Question: Produce a descriptive caption suitable for publication.
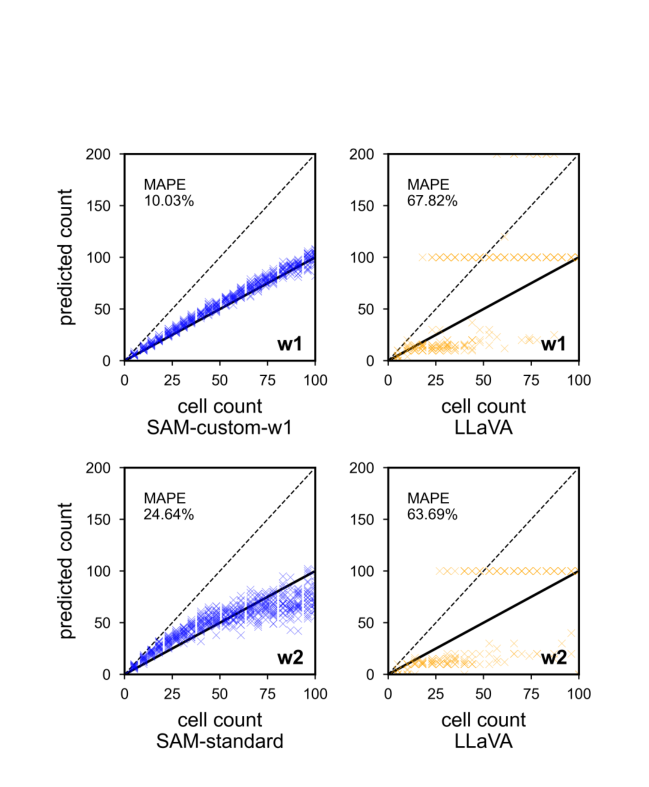
Answer: Predicted cell counts for the 1200 image subset of the BBBC005 dataset plotted against the actual counts, for LLaVA and SAM. Counts by SAM on w1 subset are shown for SAM-custom-w1 parameters, while counts on w2 dataset are shown for SAM-standard parameters, both best performing parameters for counting task. Mean absolute percent error (MAPE) is included for quantitative comparison.